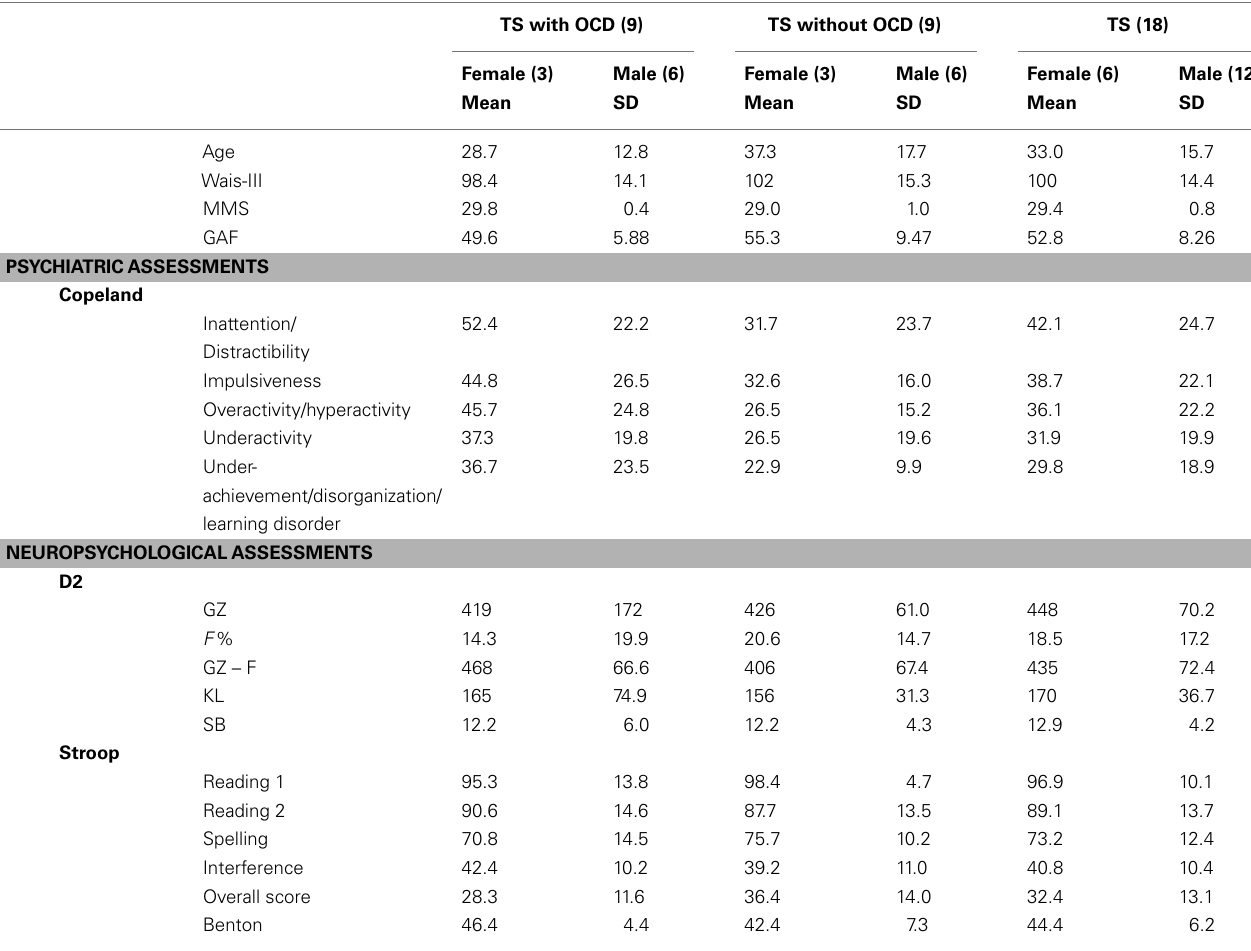
Table 3 | Summary of scores on psychiatric and neuropsychological